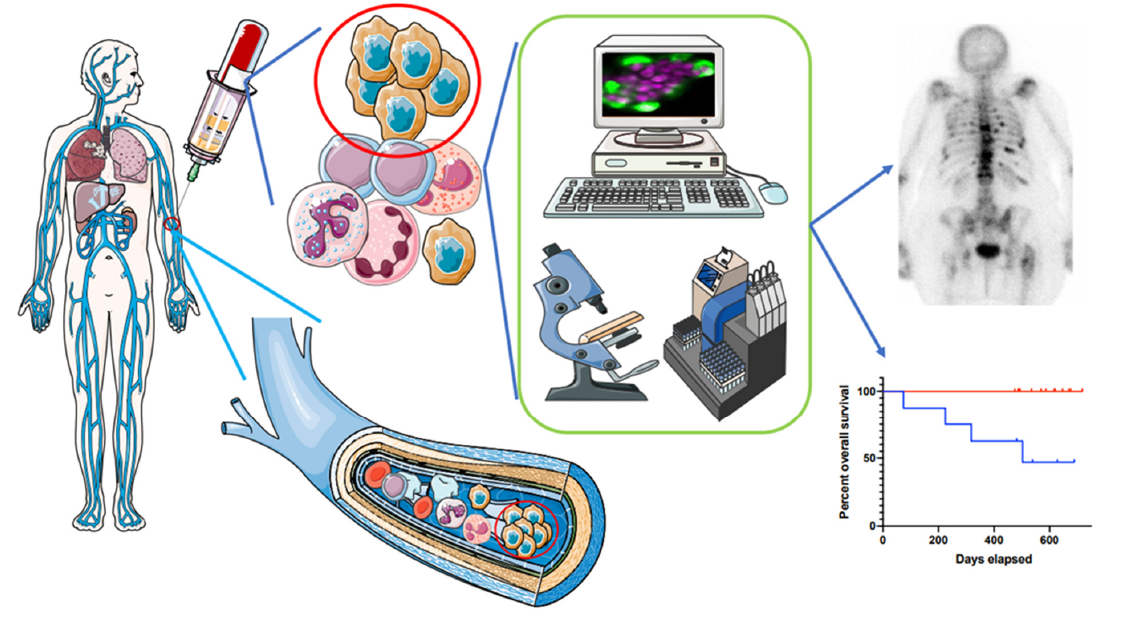
Figure 3. CTC clusters in clinical perspective. In the course of patient management, CTC cluster enumeration individualized from CTC detection might provide additional noninvasive information on patient prognosis, and might be a good companion biomarker of metastatic disease assessment. Further individual characterization of cells within CTC clusters will be helpful to measure intra-tumor heterogeneity and drug sensitivity / resistance. This figure was performed using free online Servier Medical Art at